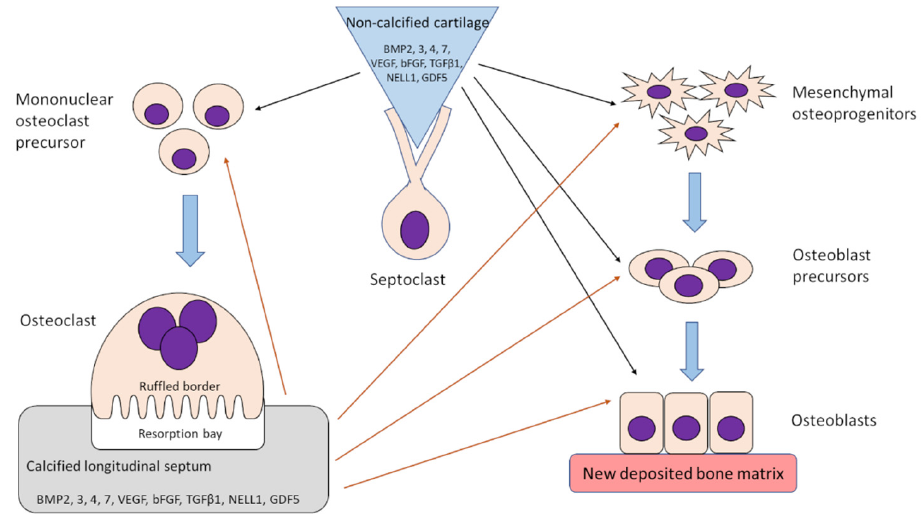
Figure 3. Tentative presentation of processes occurring during endochondral bone formation in calves. Septoclasts release growth factors from the non-calcified (black arrows) and osteoclasts from the calcified (red arrows) part of the longitudinal septa. These growth factors stimulate formation of osteoclasts from mononuclear precursors as well as differentiation of mesenchymal cells towards osteoprogenitors, osteoblast precursors and finally osteoblasts. The cooperation of septoclasts and osteoclasts during bone formation is probably similar also in other species, but the profile of growth factors present in non-calcified and calcified cartilage was, as yet, identified only in calves.